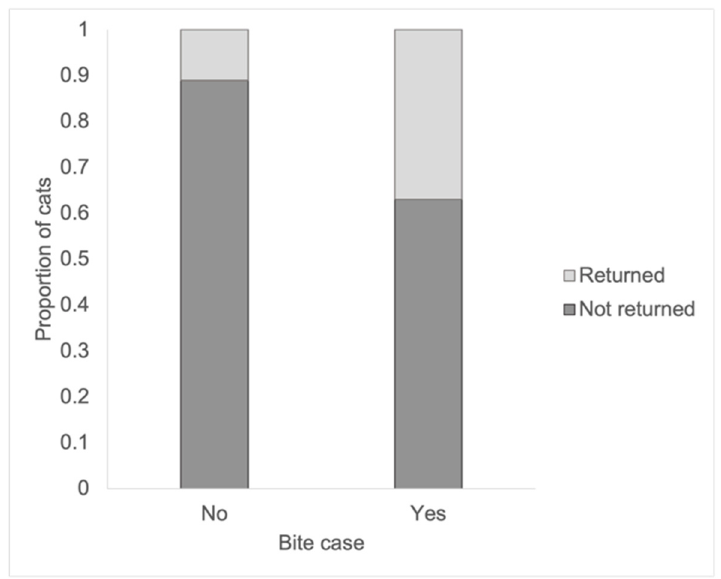
Figure 2. Proportion of cats returned and not returned by whether they were classified as a bite case while at the shelter. Significantly more cats with a history of biting were returned as compared to cats without a bite history.